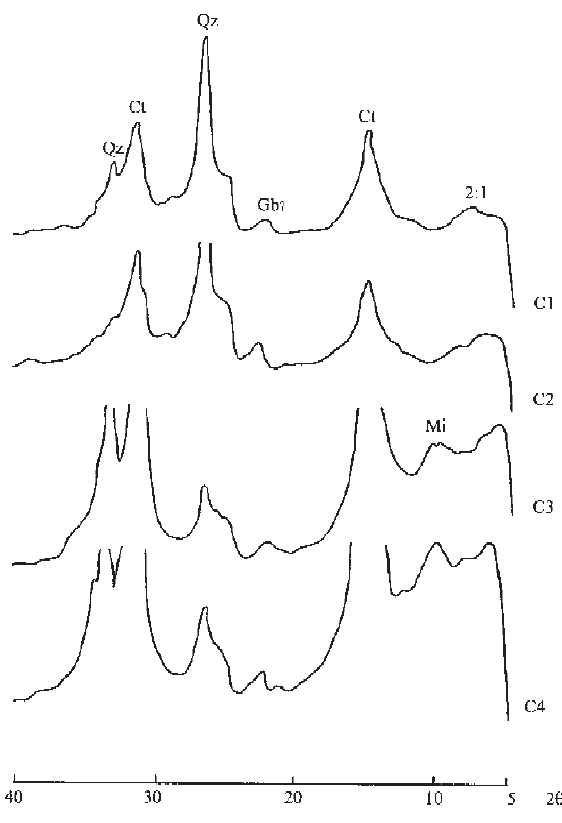
Figura 3. Difratogramas de raios-X das concreções desferrificadas de ferro e manganês trituradas e tratadas com ditionito - citrato - bicarbonato de sódio (Ct - caulinita; Qz - quartzo; Gb - gibbsita; Mi - mica e Es - Esmectita).